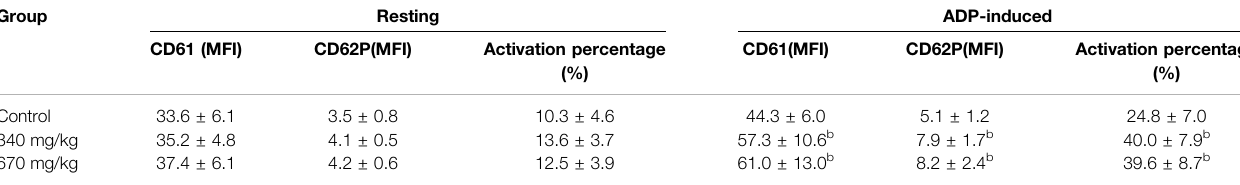
TABLE 3 | Expressions of platelet membrane glycoproteins after being treated with YNBY under resting or ADP-activated status ( (cid:1) x ± s, n (cid:1) 10). Group